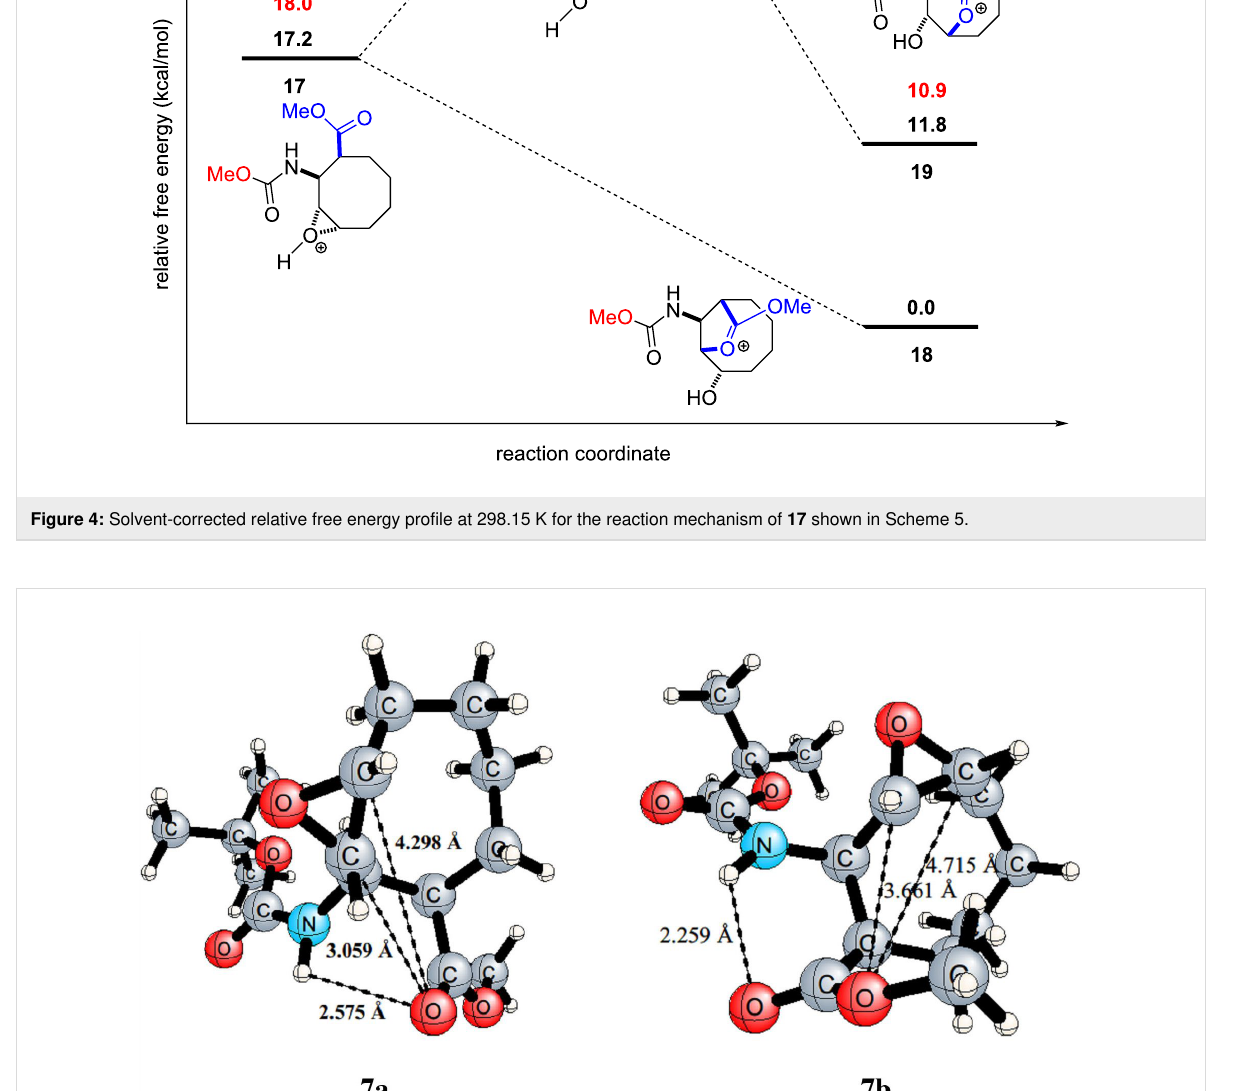
formation of the five-membered lactone is kinetically more favourable, and the formation of six-membered lactone is not feasible under the experimental conditions. The conformation of epoxide 7 is quite appropriate for the